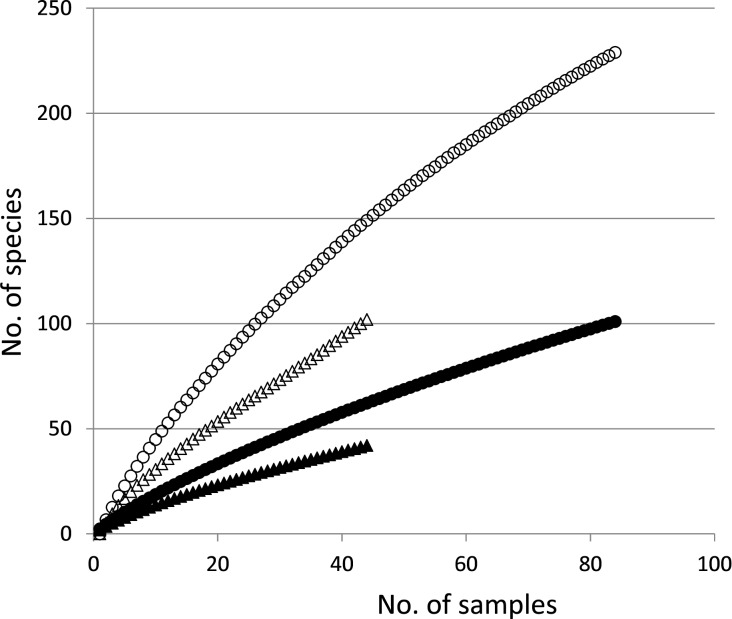
Sample-based rarefaction curves for ectomycorrhizal (ECM) fungi found in Pinus amamiana forests.Black circles and triangles represent observed ECM fungal species richness for all host species and for P. amamiana, respectively. Jackknife2 minimal species richness estimates of ECM fungi are also shown for all host species (white circles) and for P. amamiana (white triangles).